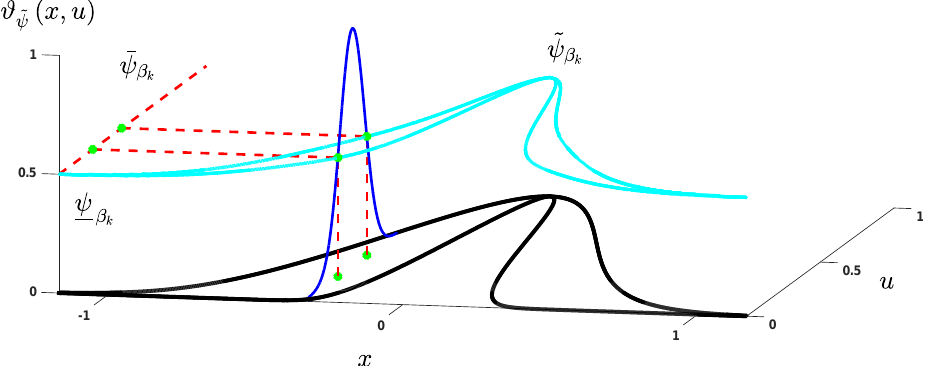
Figure 3. Proposed membership